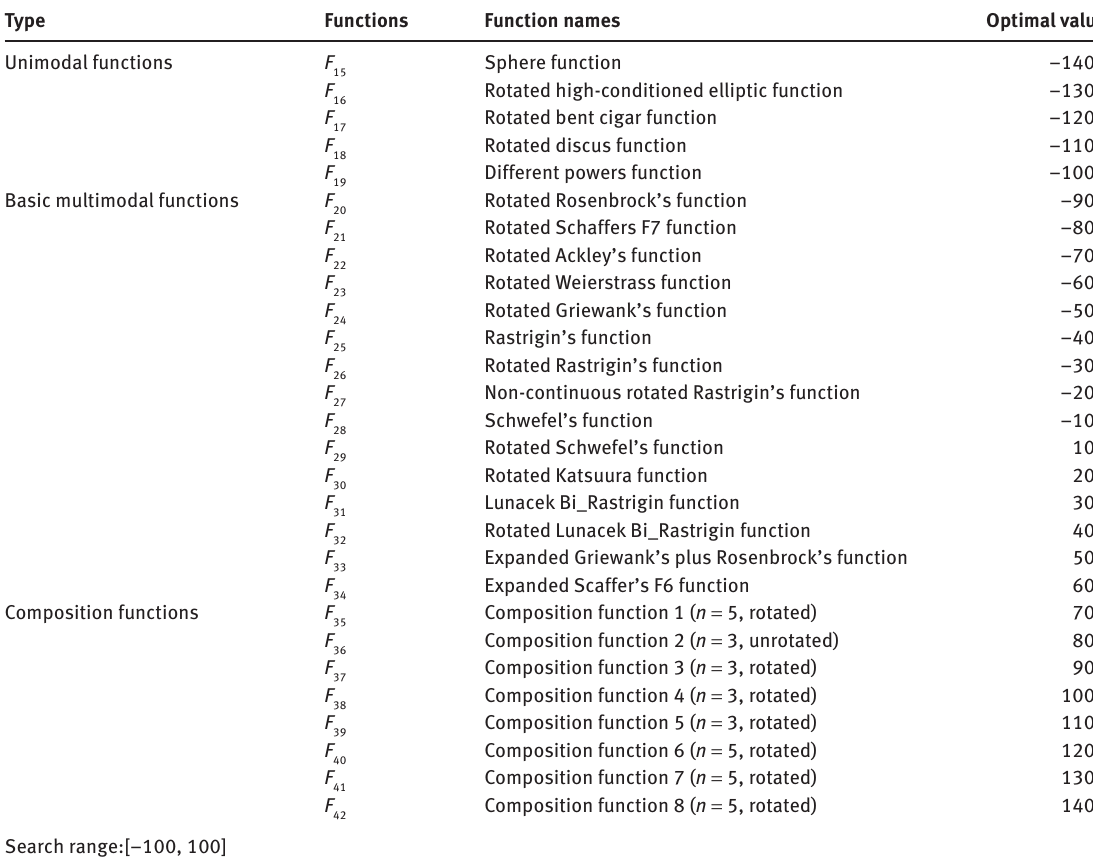
Table 5: CEC’2013 Test